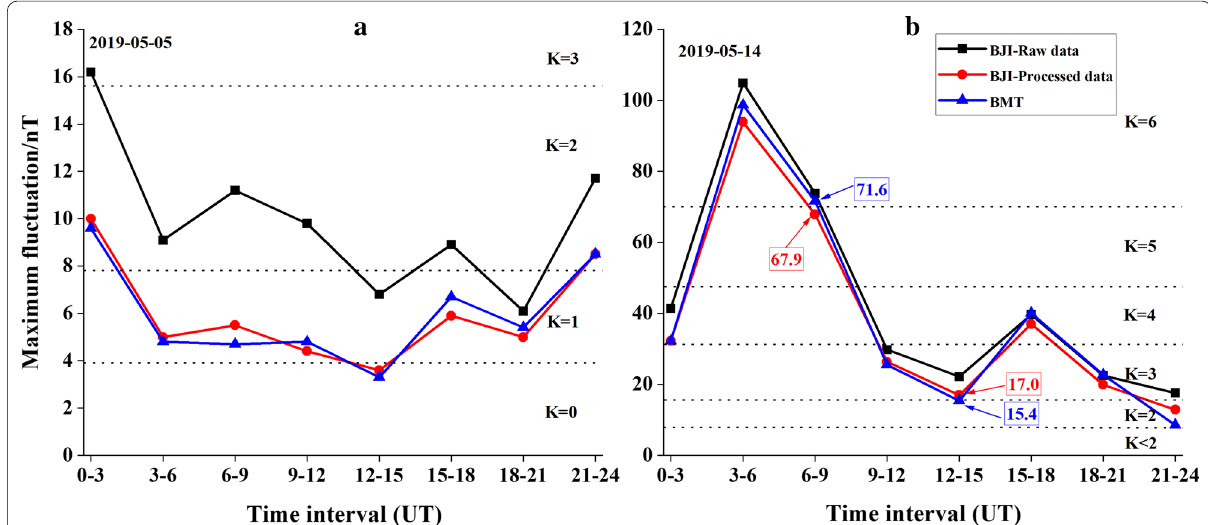
Fig. 6 Maximum fluctuations in a 3-h interval for the raw data collected at BJI (black), the processed data by the adaptive Kalman filter (red), and data collected at BMT (blue). The dotted lines represent the upper limits of fluctuation ranges for K-indices